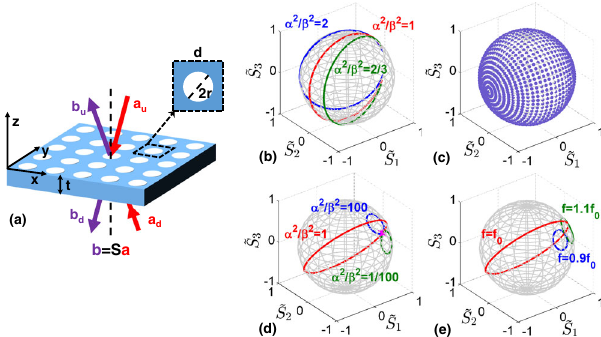
Fig. 1 Polarization manipulation and its coherent control. a Schematic of the photonic crystal slab. b – e Polarization control as we vary: b the excitation frequency; c the background re fl ectivity and phase difference of the two input beams around the BIC point; d the phase difference of the two input beams at the BIC frequency with different radiative coupling rate ratio when operating at the BIC point α ¼ β ¼ 0 (scatter) and β ¼ 0 : 01,0.1,1 with fi xed α ¼ 0 : 1 (solid line); e the phase difference of the two input beams ¼ 1, α 2 ¼ 0 : 01, under the critical coupling condition α ¼ β ¼ 0 : 1. In b f 0 β 2 ¼ 0 : 005 ; 0 : 01 ; 0 : 015 and f varies from 0.9 to 1.1. In d r ¼ 0 : 95. 0 ¼ 0 : 95 and f ¼ 1. N = 0 is in all fi In e r 0 0